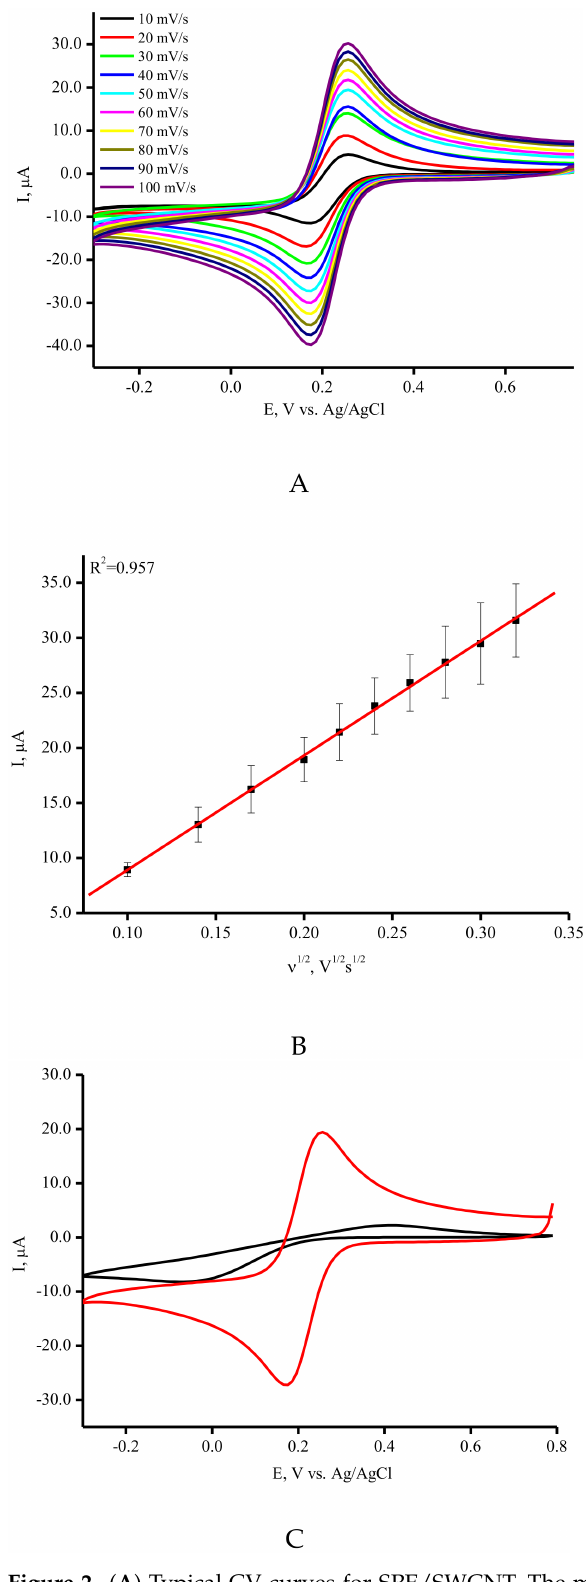
Figure 2. ( A ) Typical CV curves for SPE/SWCNT. The measurements were carried out in 5 mM K 3 Fe(CN) 6 at ambient temperature in a potential range from − 400 mV to +800 mV (vs. Ag/AgCl) at scan rates in the range of 10–100 mV/s. ( B ) The dependence of peak current Ip on the square root of the scan rate in the range of 10–100 mV/s. ( C ) The typical CV curves for SPE (-) and SPE/SWCNT (-) in 5 mM K 3 Fe(CN) 6 at 50